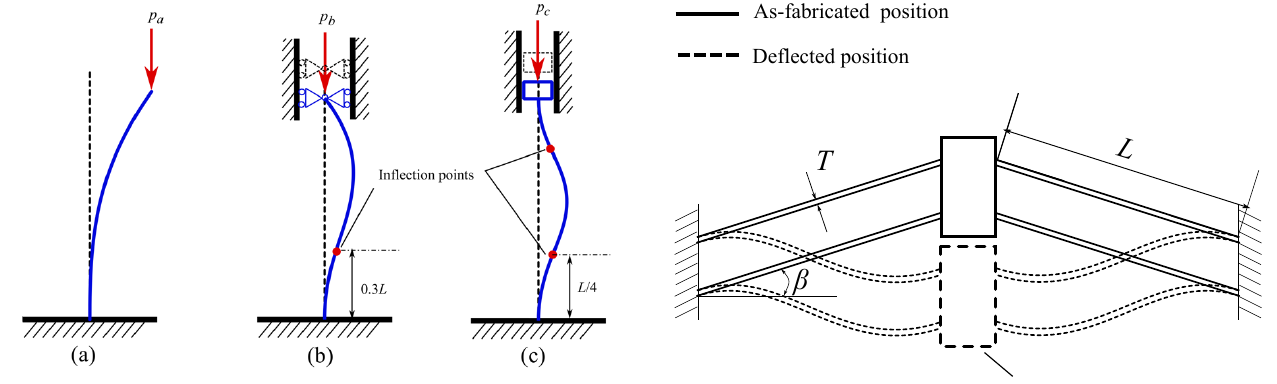
Figure 6. (a) fixed-free beam buckling; (b) fixed-pivot beam buck- ling; (c) fixed-fixed beam buckling. Figure 7. A bistable mechanism.